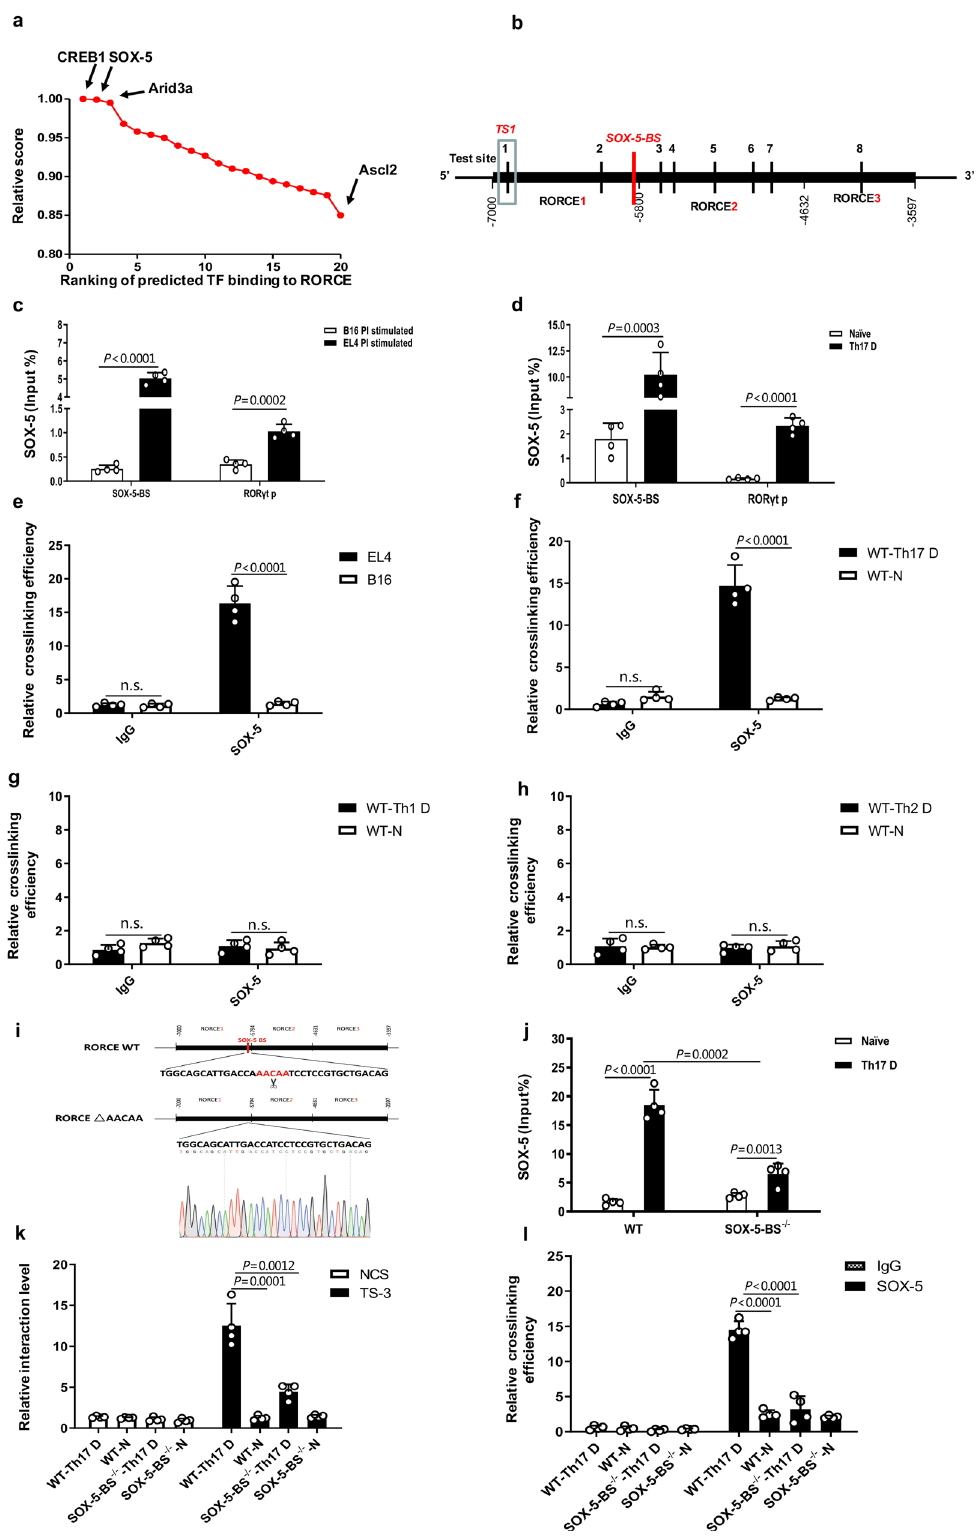
expression was quanti fi ed using the △△ Ct method, and glyceraldehyde 3- phosphate dehydrogenase (GAPDH) was used as an internal control. The qPCR primers are listed in Supplementary Table 4. (STEMCELL) according to the manufacturer ’ s instructions. Sorted naïve CD4